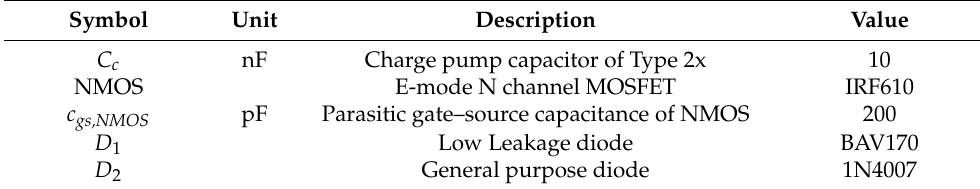
Table 3. Parameters of the Type 2x power